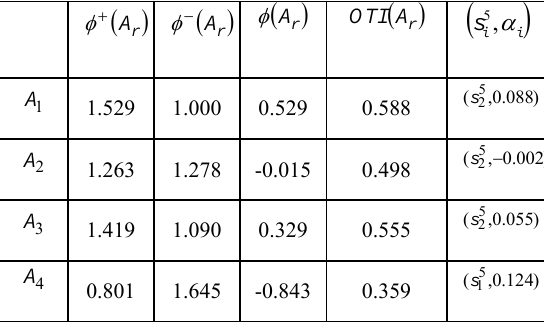
Table 18. The final result of each logistics